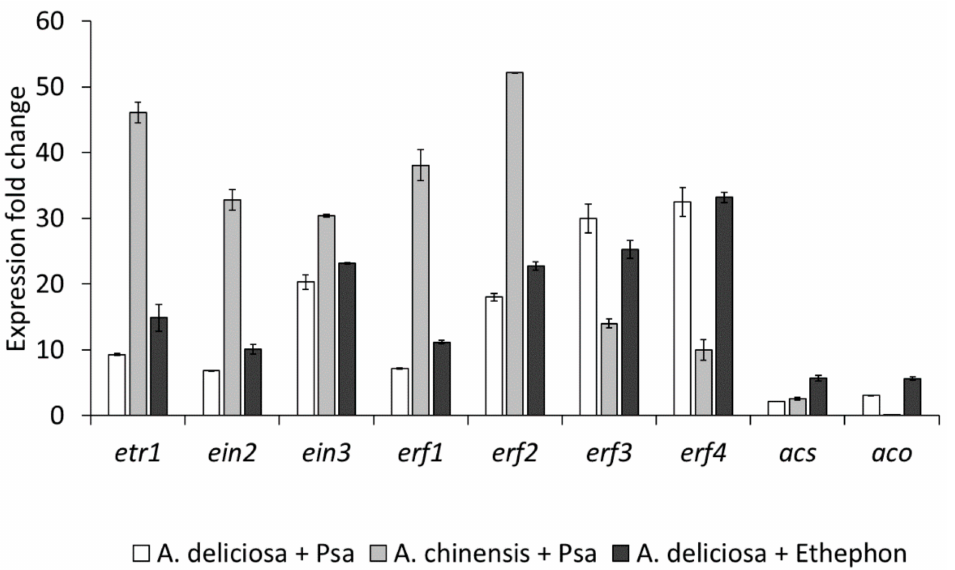
Figure 10. Expression of genes related to ethylene signalling in in vitro Actinidia deliciosa and A. chi- nensis plants. Gene expression was measured 6 h after inoculation with Pseudomonas syringae pv. actinidiae strain CFBP7286, or after treatment with ethylene. Data are expressed as fold change of relative gene expression, calculated with relation to housekeeping genes, compared to untreated plants of the same species. Values are presented as the average ± standard error ( n =